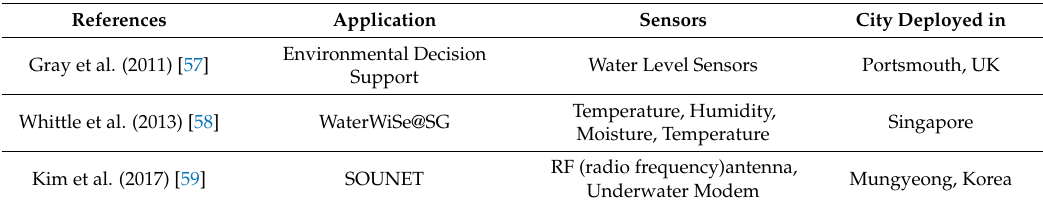
Table 7. Examples of prototyped applications for underwater